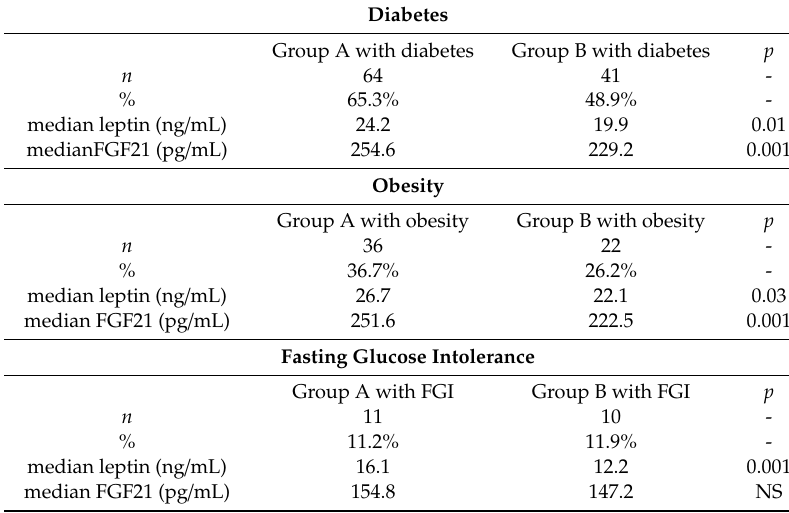
Table 3. Relationship between protein concentrations and metabolic disorders in patients from group A and group